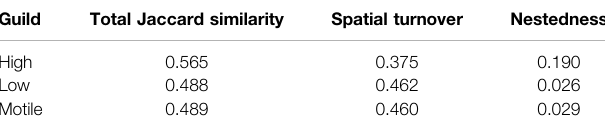
TABLE 2 | Turnover and nestedness partition of the Jaccard index by